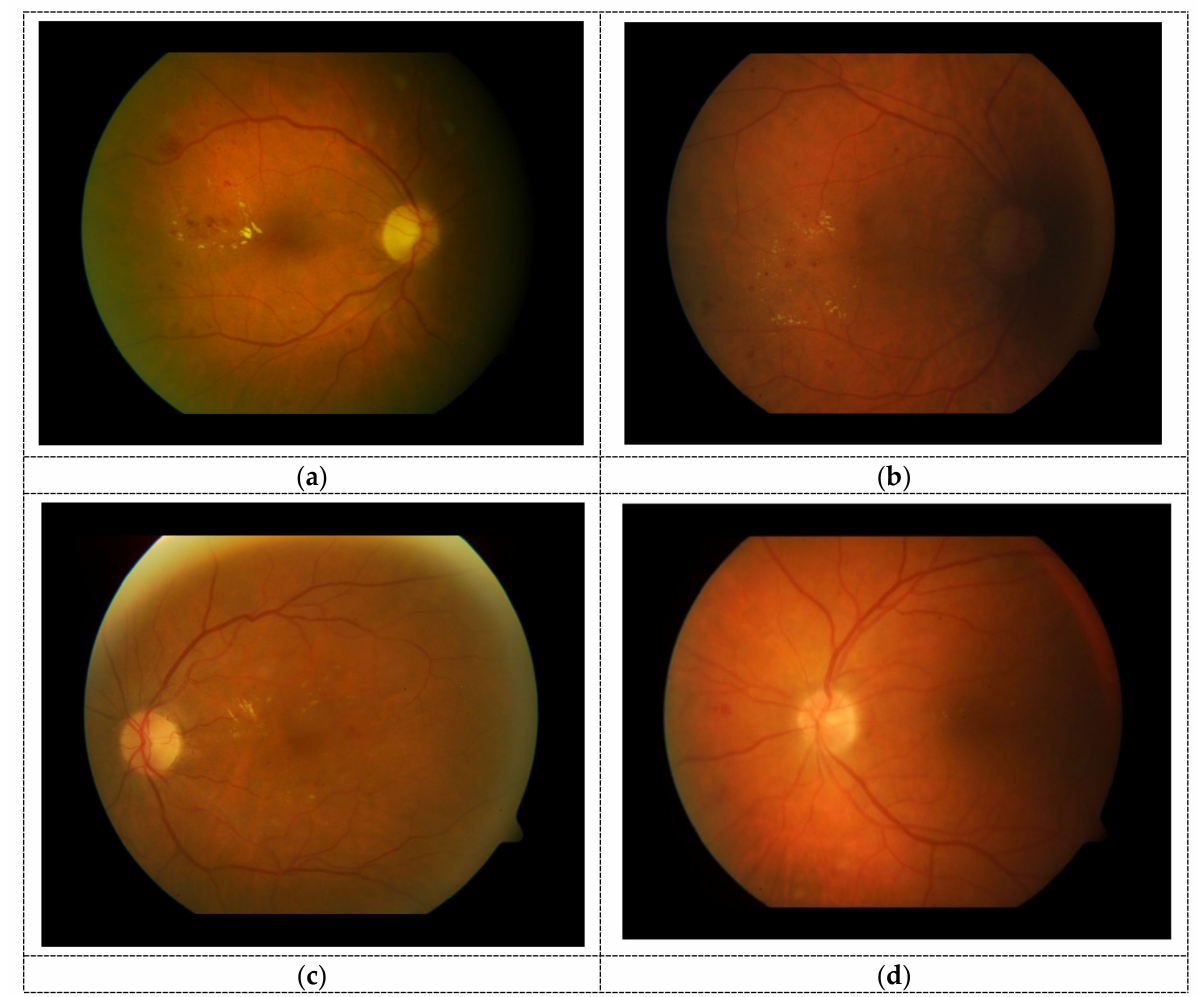
Figure 1. Example of retinal images, ( a , b ) dark images, ( c , d ) uneven illumination of fundus images. The problems of retinal images necessitated an algorithm that can segment hemor- rhages efficiently and accurately. The proposed algorithm first enhances the contrast of the fundus image with the adaptive histogram equalization. Then the edge information manipulates the intensity transformation adaptively to make the hemorrhage appear more prominently. Next, a fuzzy-logic-based filter is used to sharpen the images. Finally, the candidate image is extracted, segmented, and classified. The major contributions of this paper are summarized as